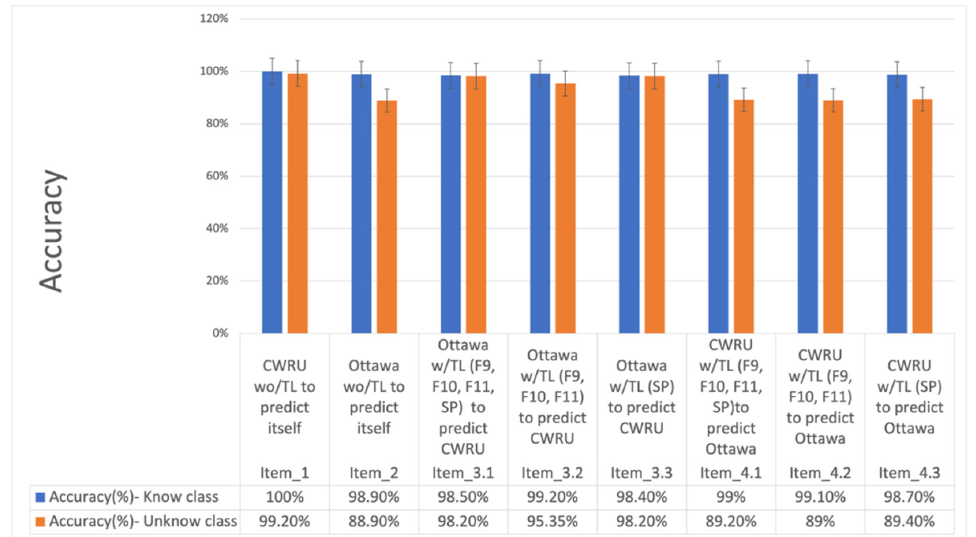
Figure 8. The experimental results demonstrate the effectiveness and efficiency of knowledge